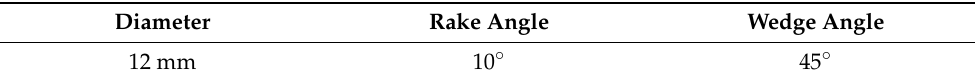
Table 2. Tool geometries.